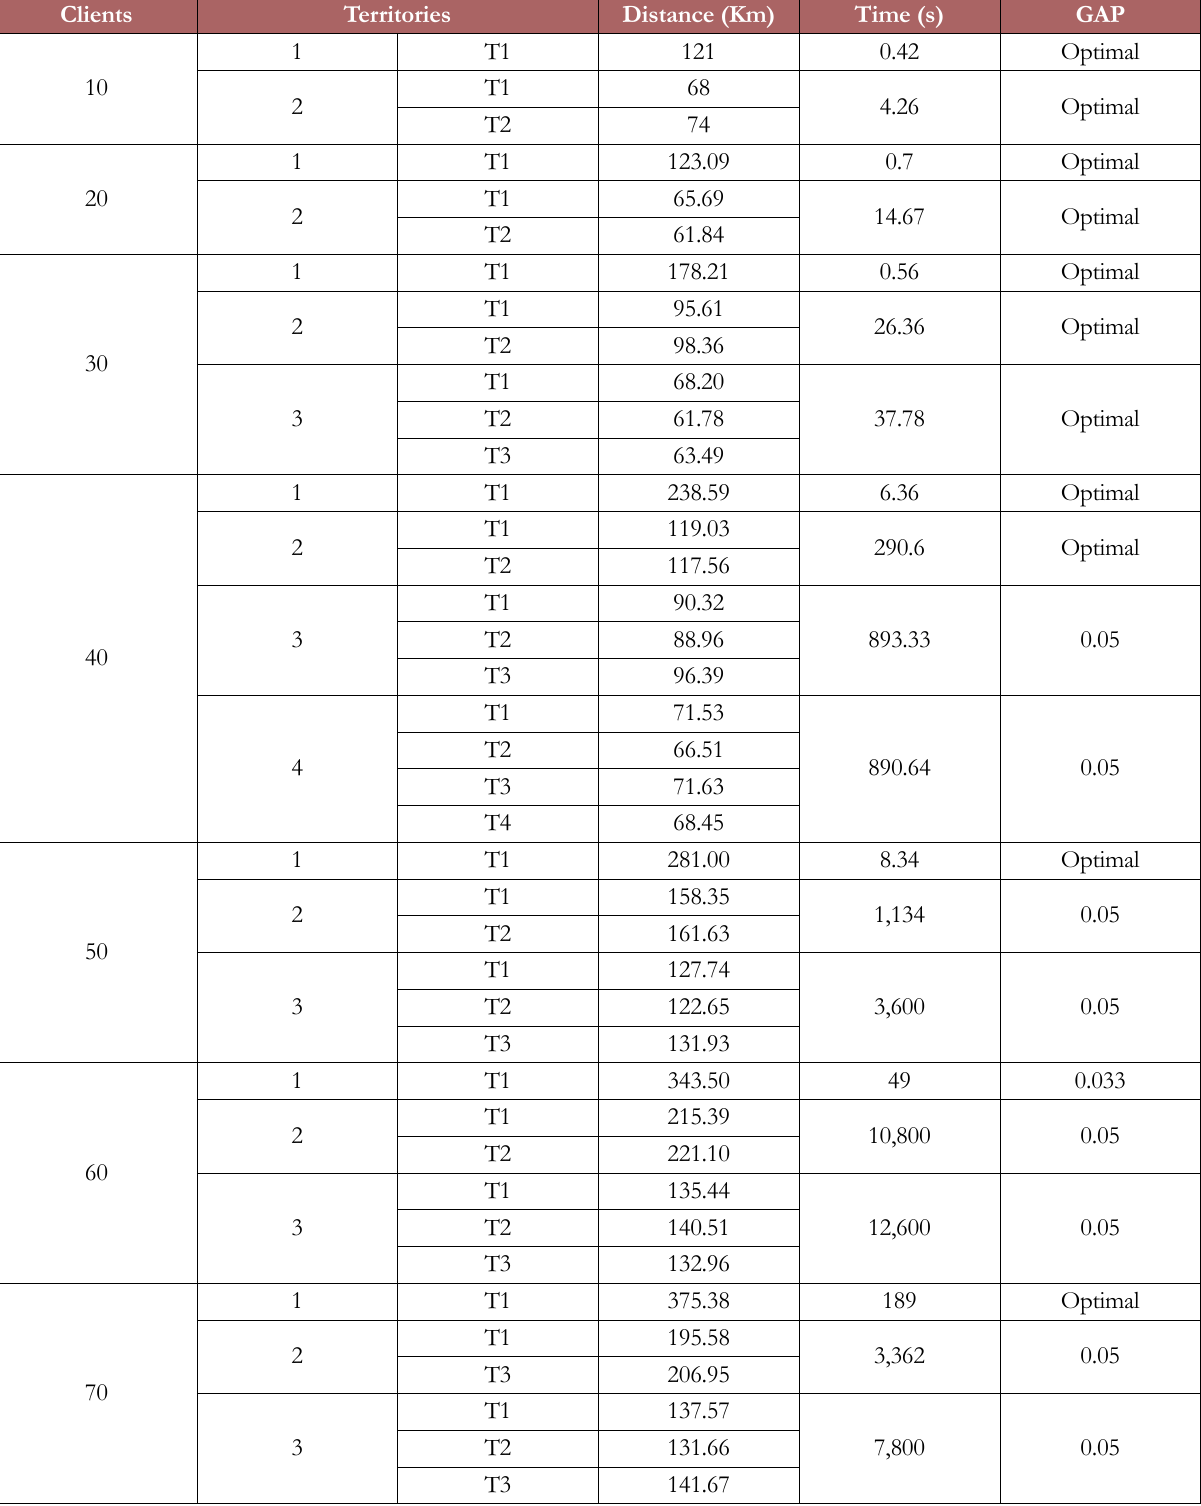
Table 3. Experimentation results with a great variation in demand